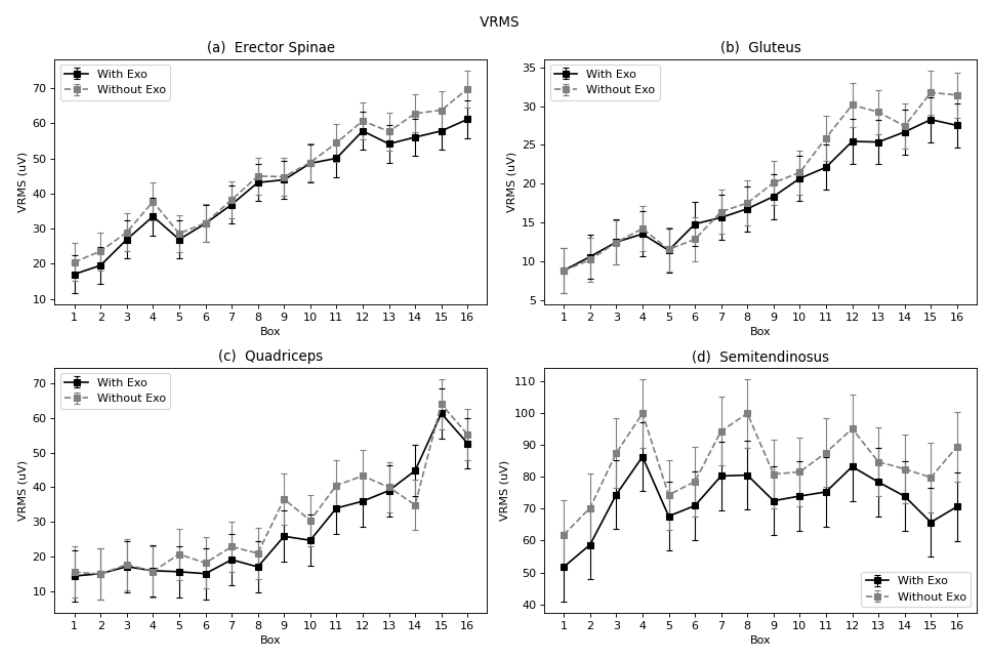
Figure 5. Marginal mean curves with the standard error bars of VRMS parameter throughout the 16 boxes for all four muscles: ( a ) Erector Spinae, ( b ) Gluteus, ( c ) Quadriceps, and ( d )